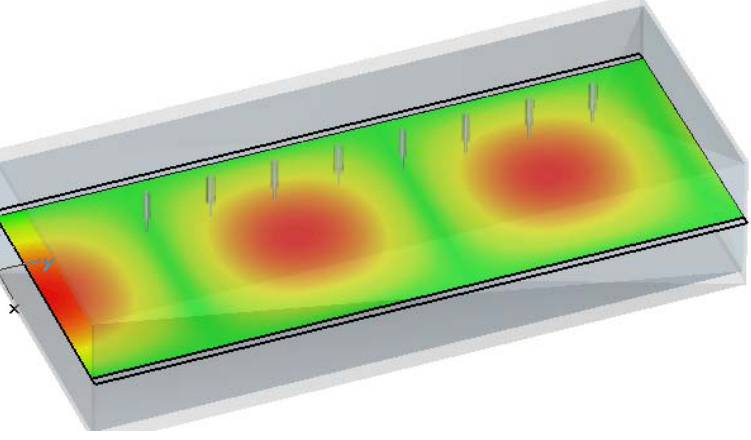
Figure 5. Electric field magnitude across a ten-port, including the effect of the metallic probes.